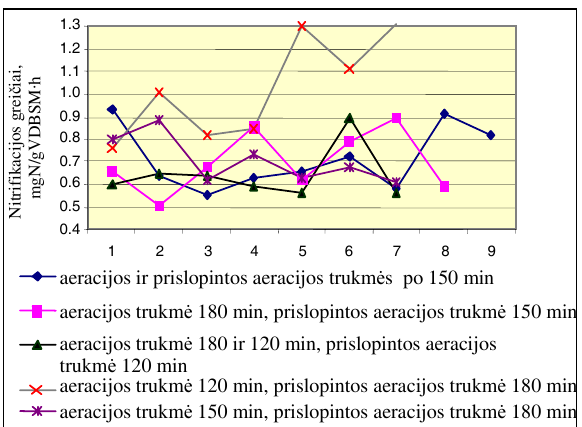
Fig 10. Concentration change of ammonium nitrogen and nitrates in the second aeration tank in the beginning and at the end of aeration at aeration rate of 120 min, and redu- ced aeration rate of 180 min